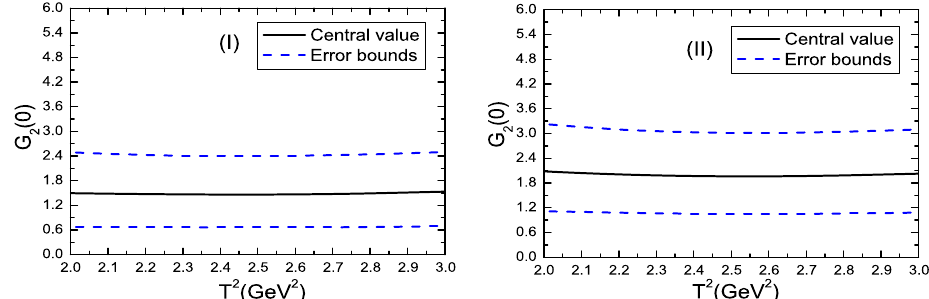
Fig. 3 The form-factor G 2 ( 0 ) with variation of the Borel parameter T 2 , where the (I) and (II) denote the parameters (I) and parameters (II), respectively